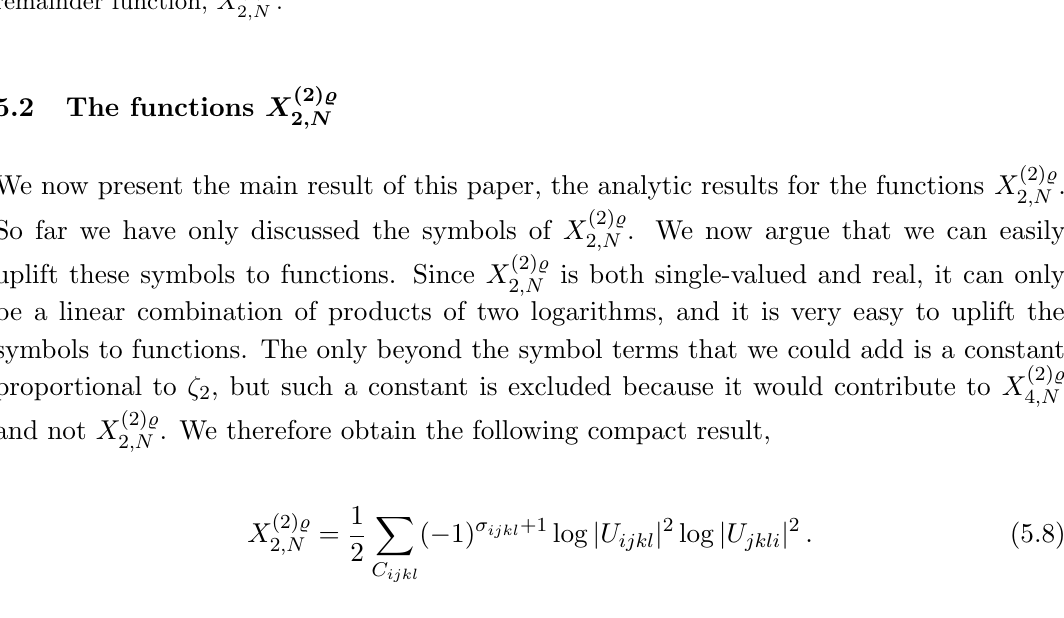
Figure 2 . Illustration of the diagrammatic method for obtaining the (2 (cid:25)i ) 2 coe(cid:14)cients of the remainder function, X (2) % 2 ;N